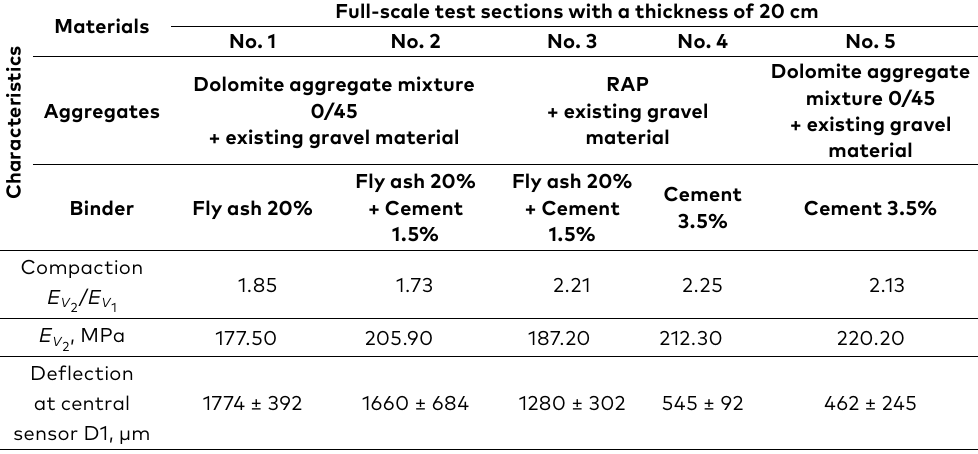
Table 4. Plate loading test and falling weight deflectometer